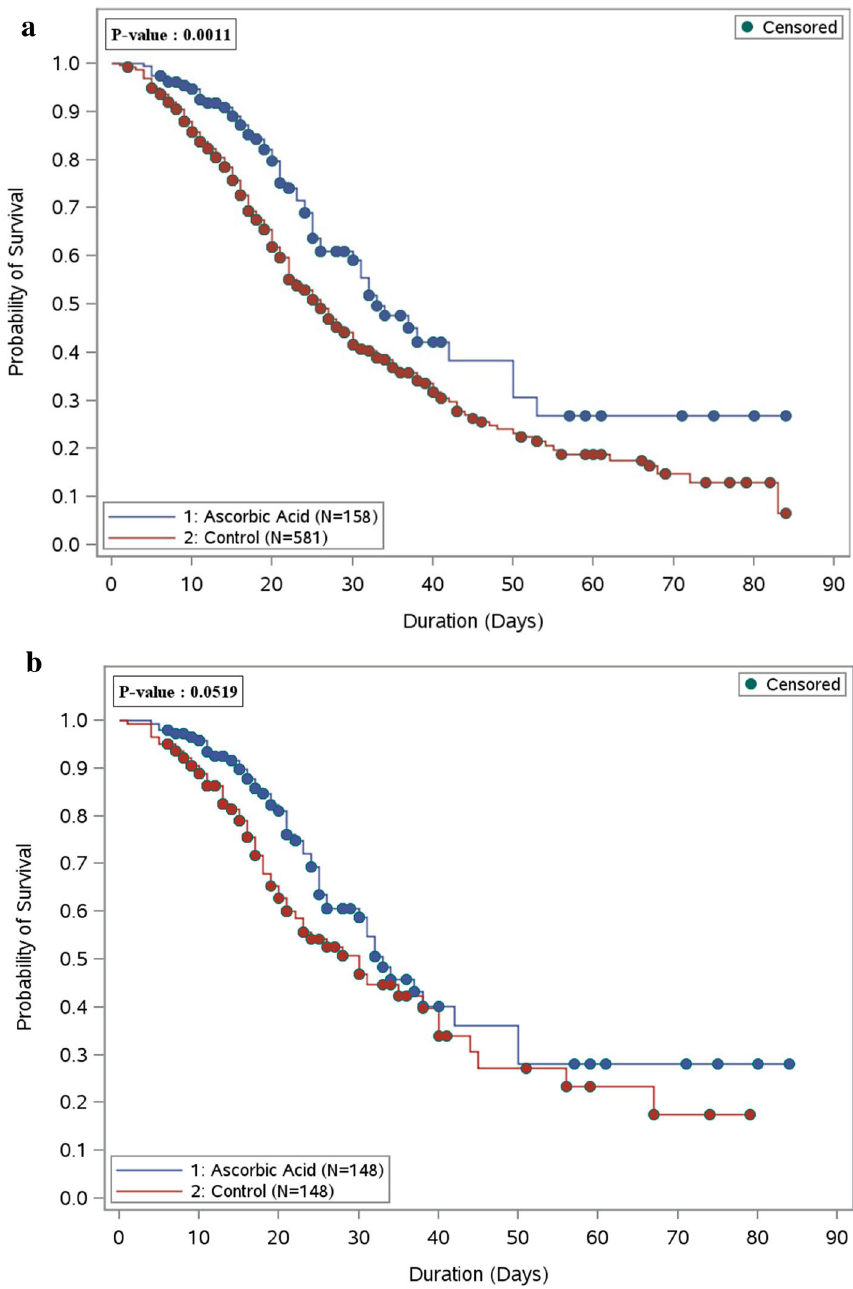
Figure 1. ( a ) Overall survival plot during the hospital stay comparing patients who received ascorbic acid (157 patients) as adjunctive therapy versus the control group (581 patients)—before PS matching. ( b ) Overall survival plot during the hospital stay comparing patients who received ascorbic acid (148 patients) as adjunctive therapy versus the control group (148 patients)—after PS